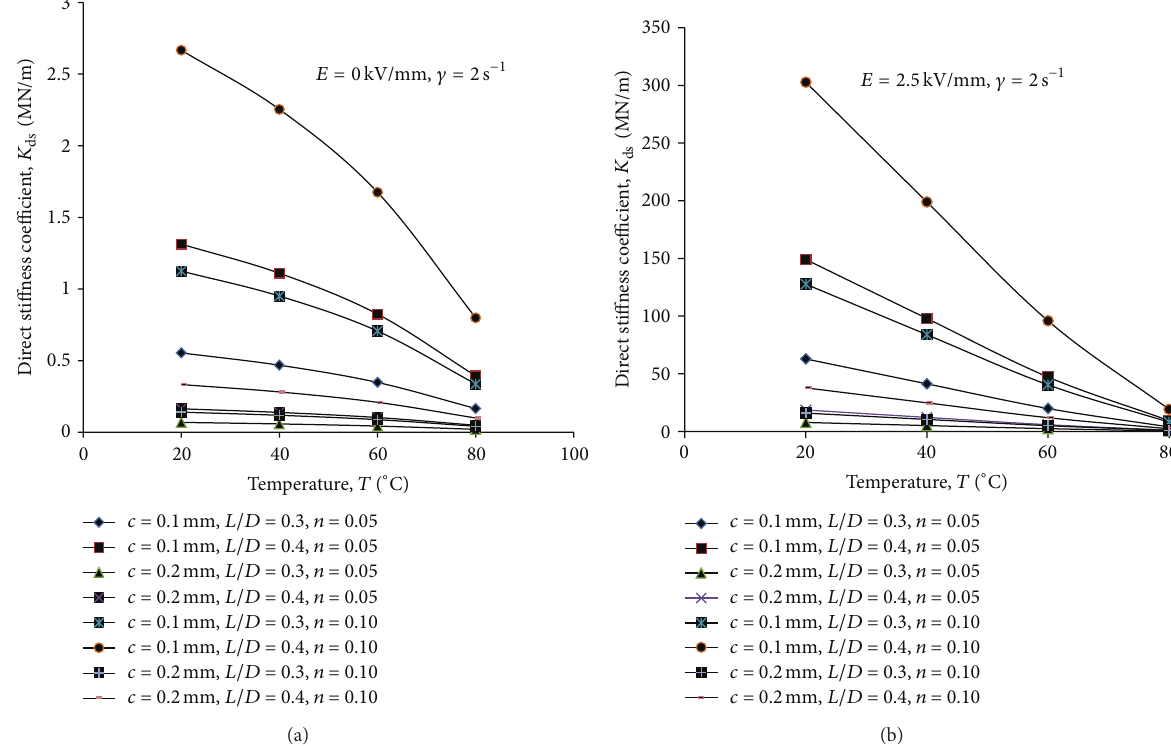
Figure 4: Direct stiffness coefficient, 𝐾 , (MN/m) versus temperature, ( ∘ C) for (a) 𝐸 = 0 kV/mm, and (b) 𝐸 = 2.5 kV/mm under a constant ds strain rate, ̇𝛾 = 2 s −1 .